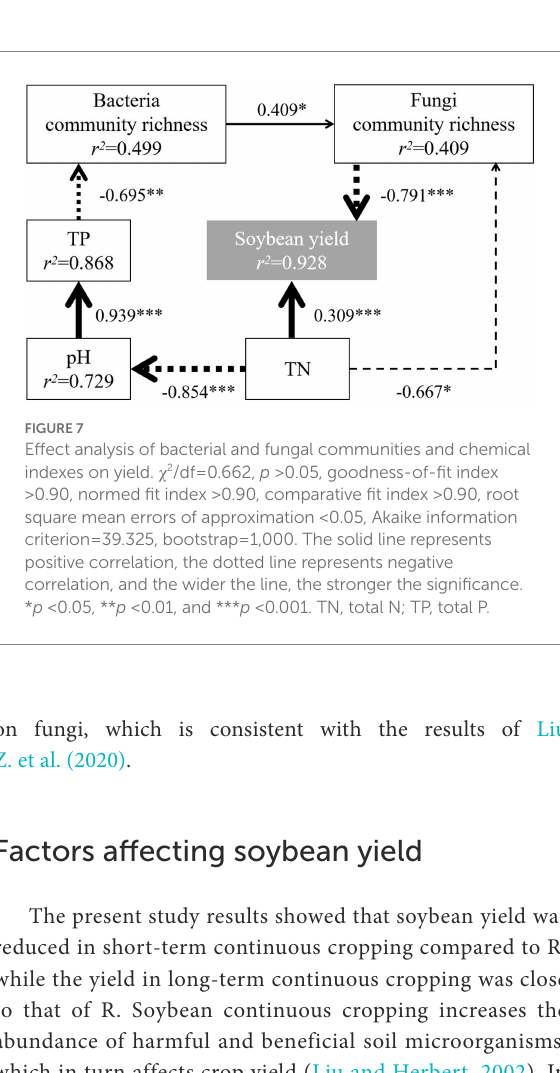
FIGURE 6 Redundancy analysis of bacterial (A) and fungal (B) communities and soil chemical properties. The generic name is the same as in Figure 3. SOM, soil organic matter; TN, total N; AN, alkali- hydrolyzed N; NH 4+ –N, ammonium N; NO 3− –N, nitrate N; TP, total P; TK, total K; C/N, ratio of C and N.